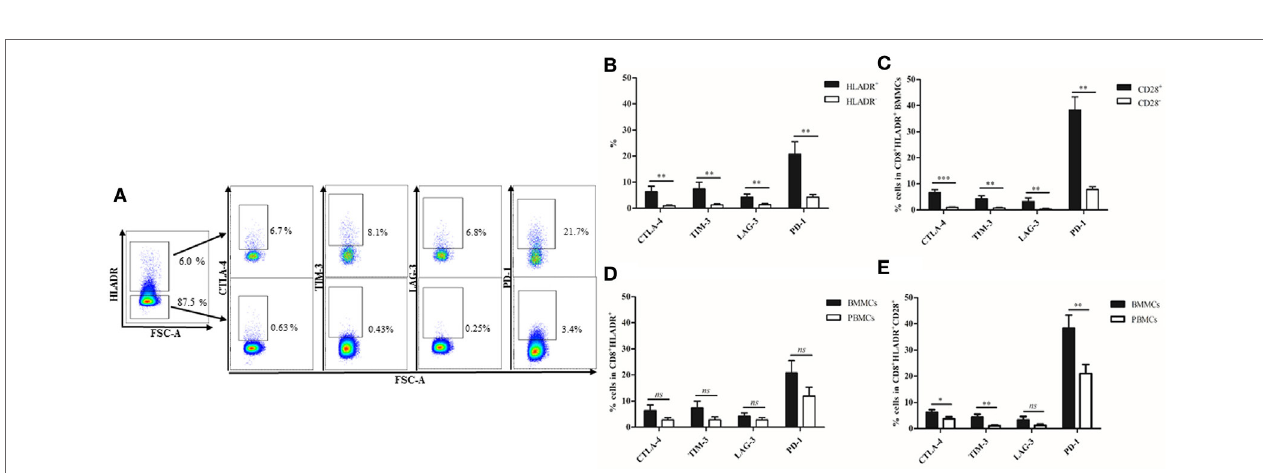
FigUre 5 | Expression of checkpoint inhibitory molecules on CD8 + human leukocyte antigen–antigen D related (HLADR) + and on CD8 + HLADR + CD28 + T cells in bone marrow mononuclear cells (BMMCs). (a) Representative FACS plots of inhibitory molecules in the CD8 + HLADR + (upper panel) and in CD8 + HLADR − (lower panel) T cell population in BMMCs. (b) Expression of checkpoint inhibitory molecules in CD8 + HLADR + vs CD8 + HLADR − cells in BMMCs; n = 8; mean ± SEM, ** p < 0.001. (c) Expression of checkpoint inhibitory molecules in CD8 + HLADR + CD28 + vs CD8 + HLADR + CD28 − cells in BMMCs; n = 8; mean ± SEM, *** p < 0.0001, ** p < 0.001. (D) Expression of checkpoint inhibitory molecules in CD8 + HLADR + in BMMCs and in PBMCs; n = 8; mean ± SEM, ns, not significant. (e) Expression of checkpoint inhibitory molecules in CD8 + HLADR + CD28 + in BMMCs and in PBMCs; n = 8; mean ± SEM, ** p < 0.001 * p <